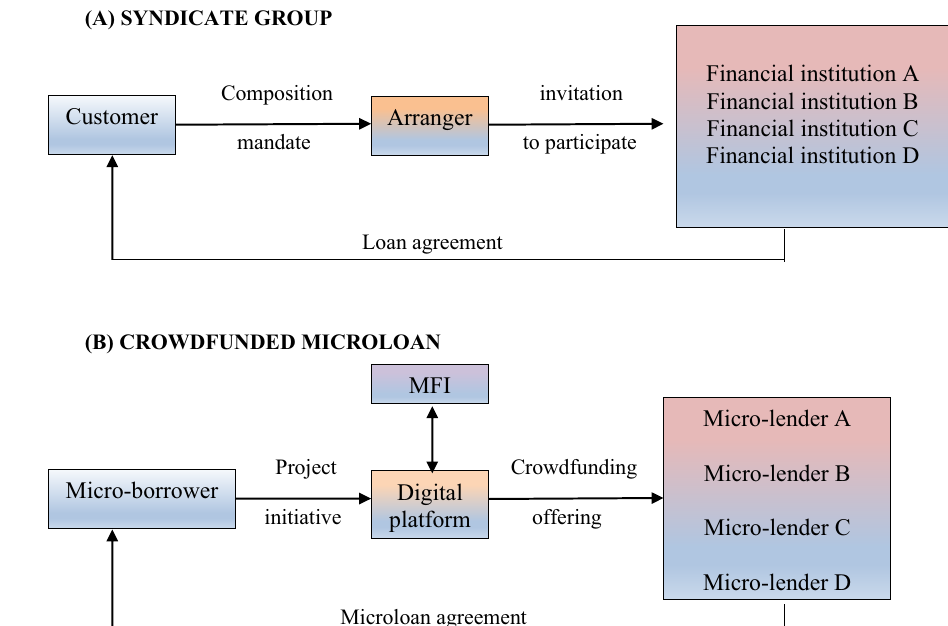
Fig. 3 Parallelism between syndicated loans and crowdfunded microloans. The schedule of fi nancing through a syndicate group and by means of crowdfunded microloans, highlighting the parallelism between both operations. A A loan agreementwhere the central role of fi nancing customers is played by the arranger and the fi nancial institutions. B The role of intermediation, played by a MFI through digital platforms, between micro-borrowers and micro- lenders. Source: Own